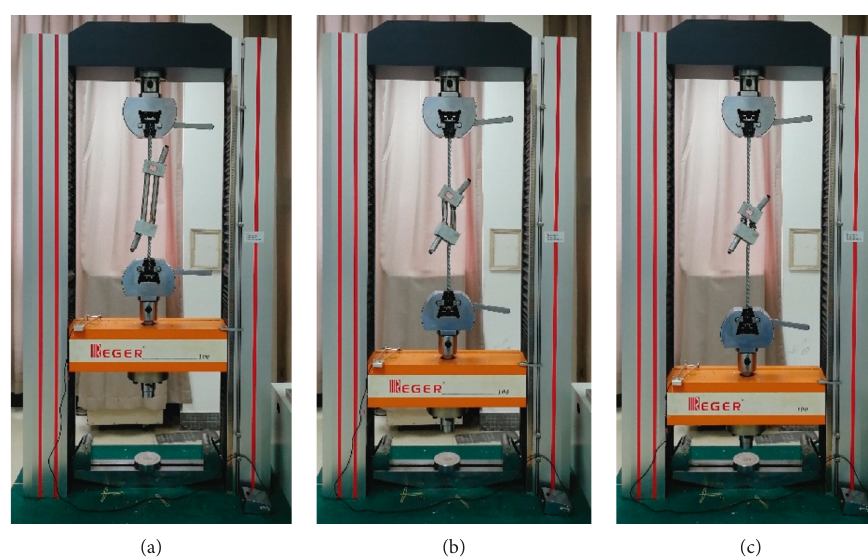
Figure 7: The quasistatic tensile process of the tube-crushing dissipator.